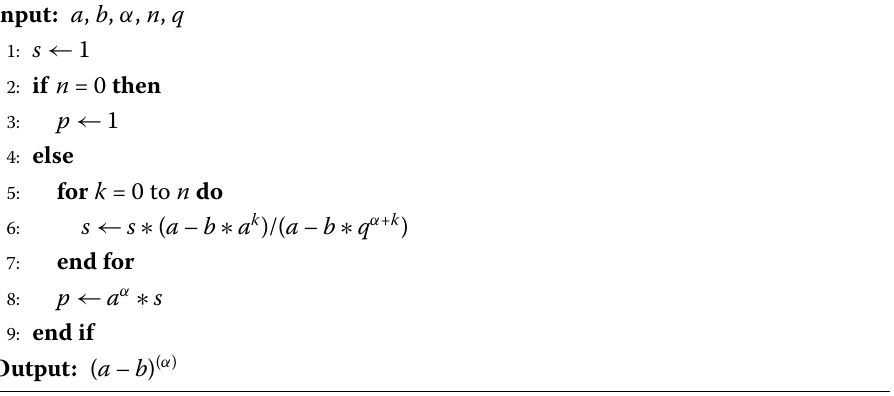
Algorithm 1 The proposed method for calculation of ( a – b ) ( α ) q